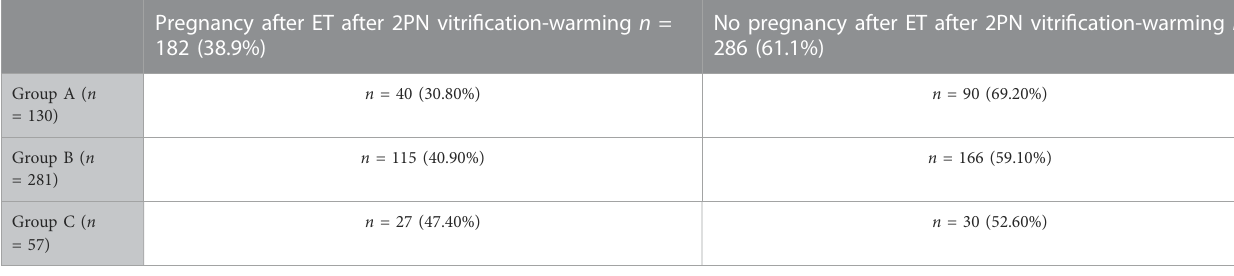
TABLE 7 Distribution of pregnancy results after different time intervals between insemination and vitri fi cation. Pregnancy after ET after 2PN vitri fi cation-warming n = 182 (38.9%)